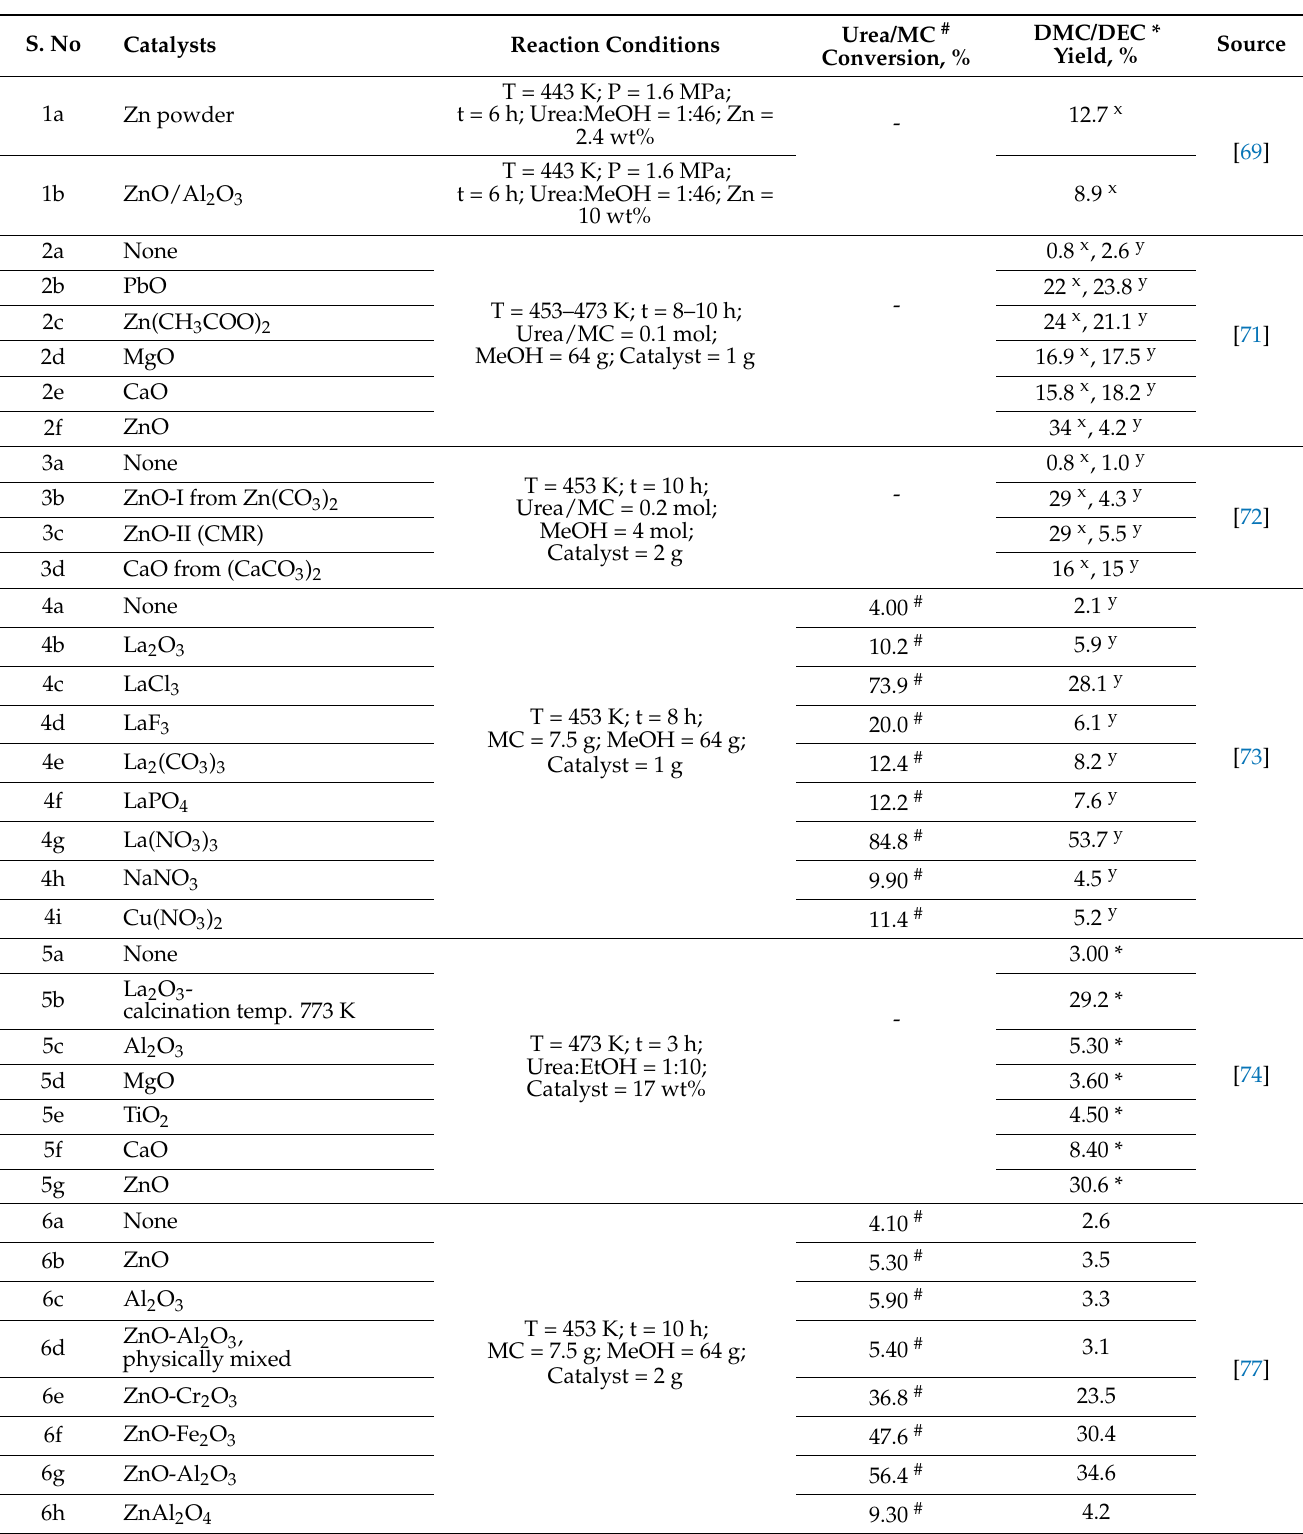
Table 3. Literature review of the catalysts used for the synthesis of DMC based on the urea alcoholysis